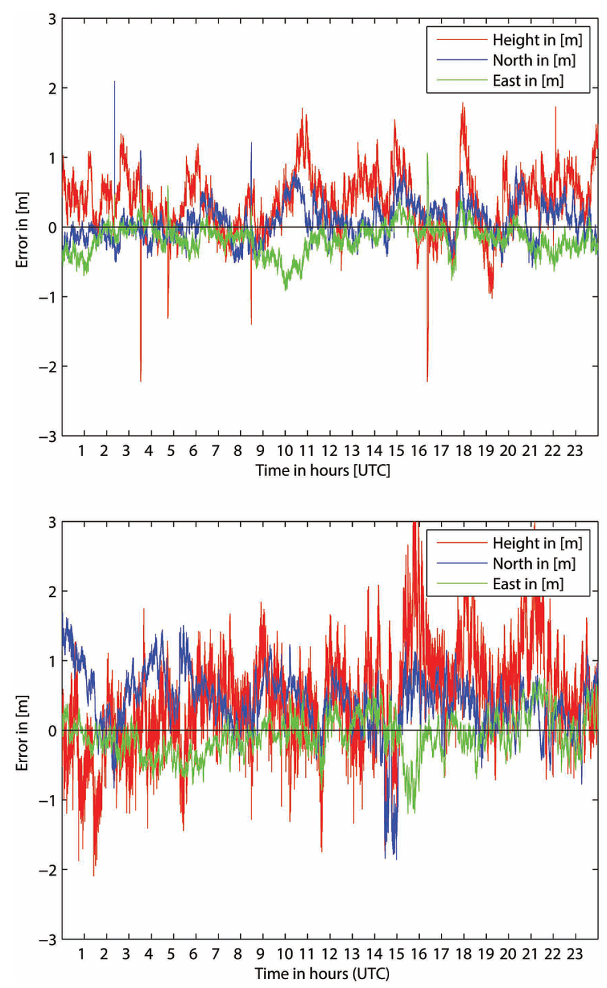
Figure A1. Top panel: position error plot of mid-range single- frequency Septentrio AsteRx1 receiver with the PolaNt survey an- tenna in SBAS/EGNOS mode of operation; 24h static test in Delft on 3 May 2011. The north, east and up position error components are plotted against time. The mean values are 0.07, − 0.18 and 0.35m for north, east and up; the standard deviations are 0.26, 0.21 and 0.44m, and the 95% values are 0.55, 0.14 and 1.05m. Bottom panel: position error plot of Septentrio AsteRx1 receiver with the patch antenna in SBAS/EGNOS mode of operation, 24h static test in Delft, on 8 August 2011. The north, east and up po- sition error components are plotted against time. The mean values are 0.00, − 0.06 and 0.30m for north, east and up; the standard de- viations are 0.77, 0.49 and 1.16m, and the 95% values are 1.08, 0.52 and